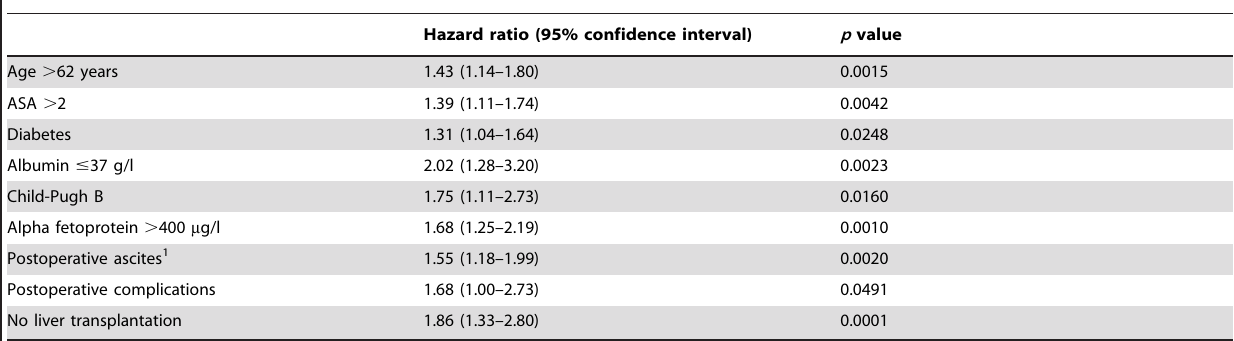
Table 3. Univariate survival analysis.